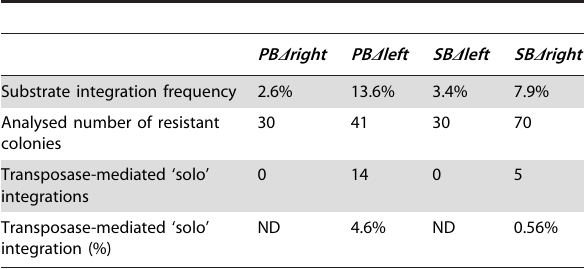
Table 1. Transposase-mediated integration events of ‘solo’